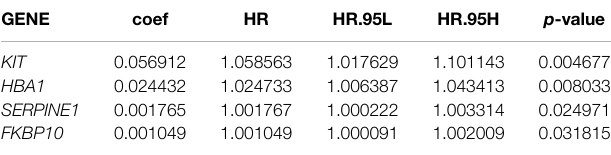
TABLE 2 | Multivariate Cox proportional hazards regression